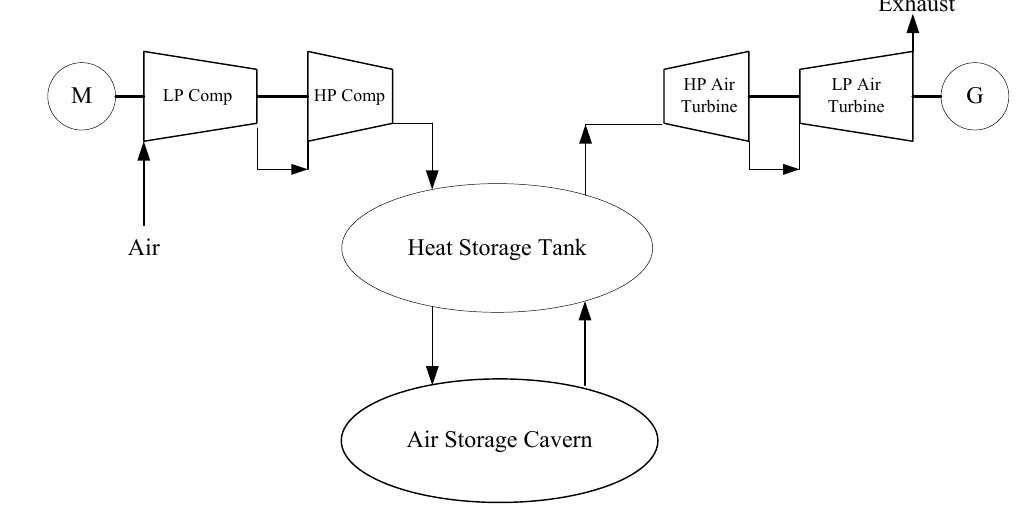
Figure 3. Diagram of the third-generation CAES